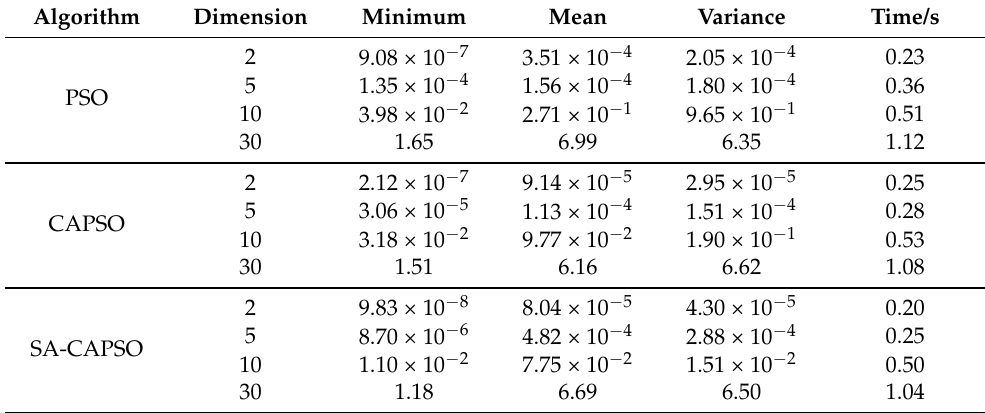
Table 6. The solution result of the test function F1.